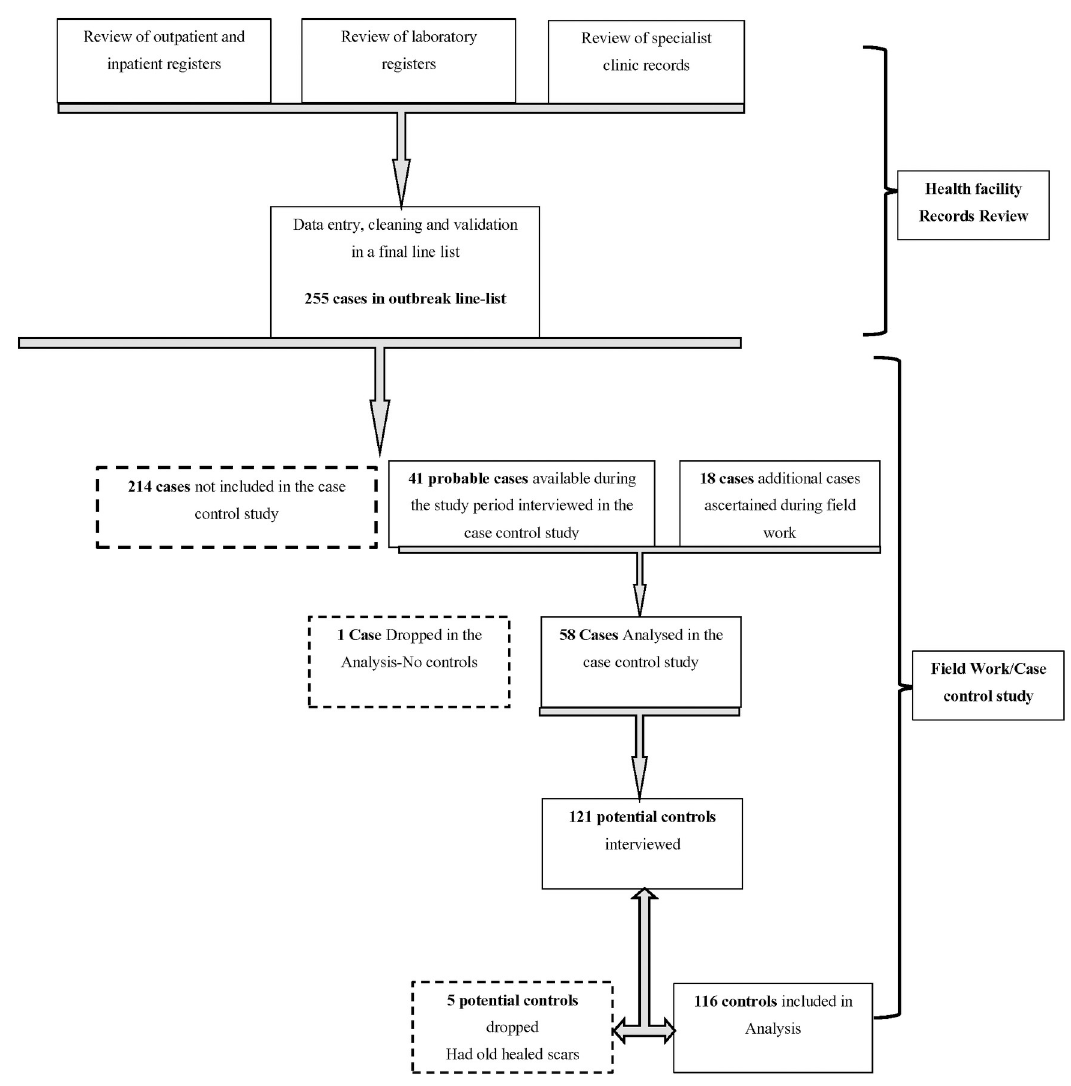
Fig 2. Flow diagram of selection of cases and controls before and after field